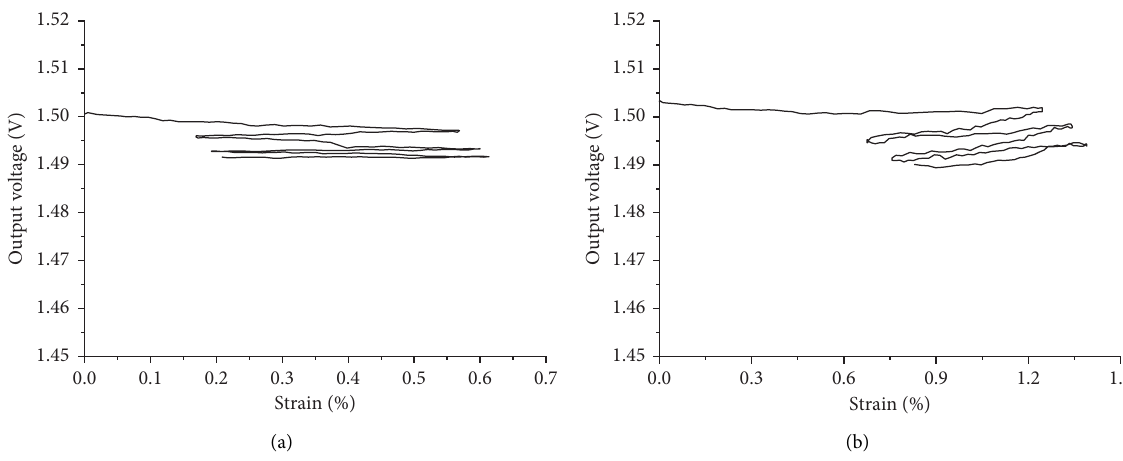
Figure 20: Voltage-strain curves of the first three cycles of PV-PVC composites. (a) Warp. (b)